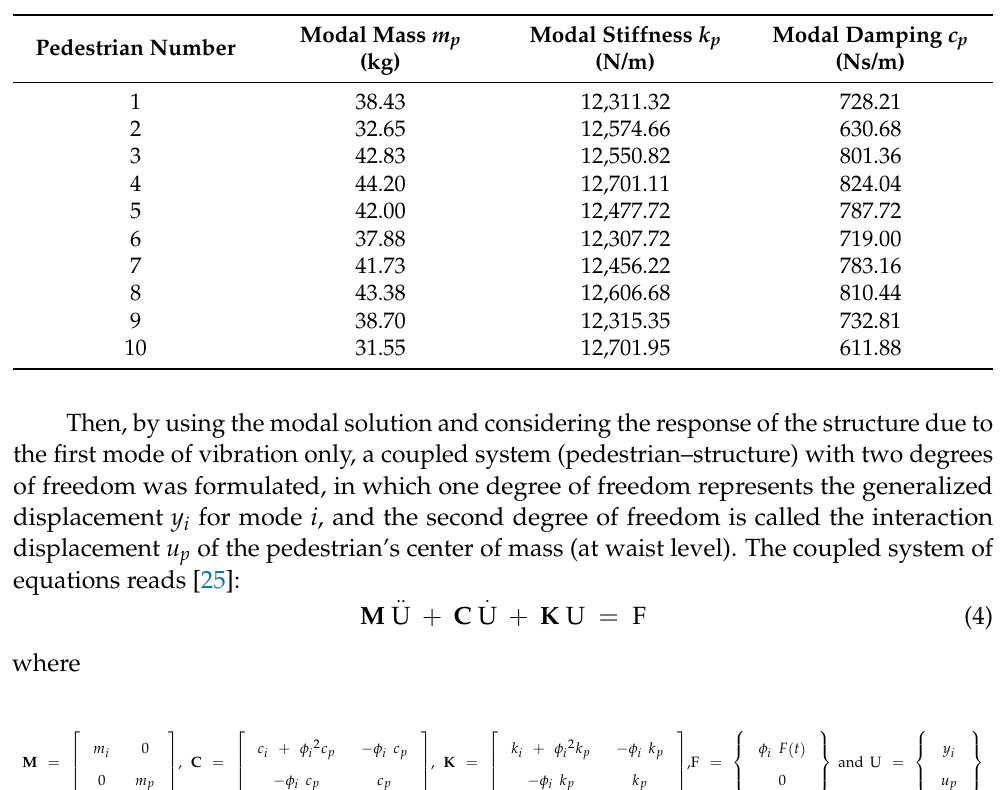
Table 2 for a pacing rate of 2.07 Hz. For the sake of completeness, the expressions employed to obtain these parameters are reproduced below: